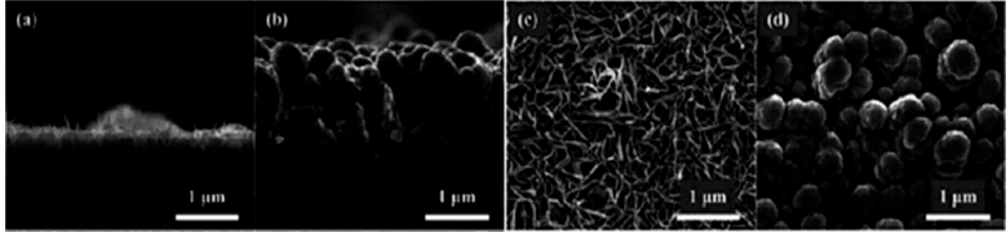
Figure 5. Thecross-sectionalandtop-viewSEMphotosofMnO 2 andMnO 2 / Alparticles. ( a )Cross-sectional of MnO 2 ; ( b ) cross-sectional of MnO 2 / Al; ( c ) top-view of MnO 2 ; and ( d ) top-view of MnO 2 / Al. Reproduced from [34], with permission from Initiators & Pyrotechnics, 2018.